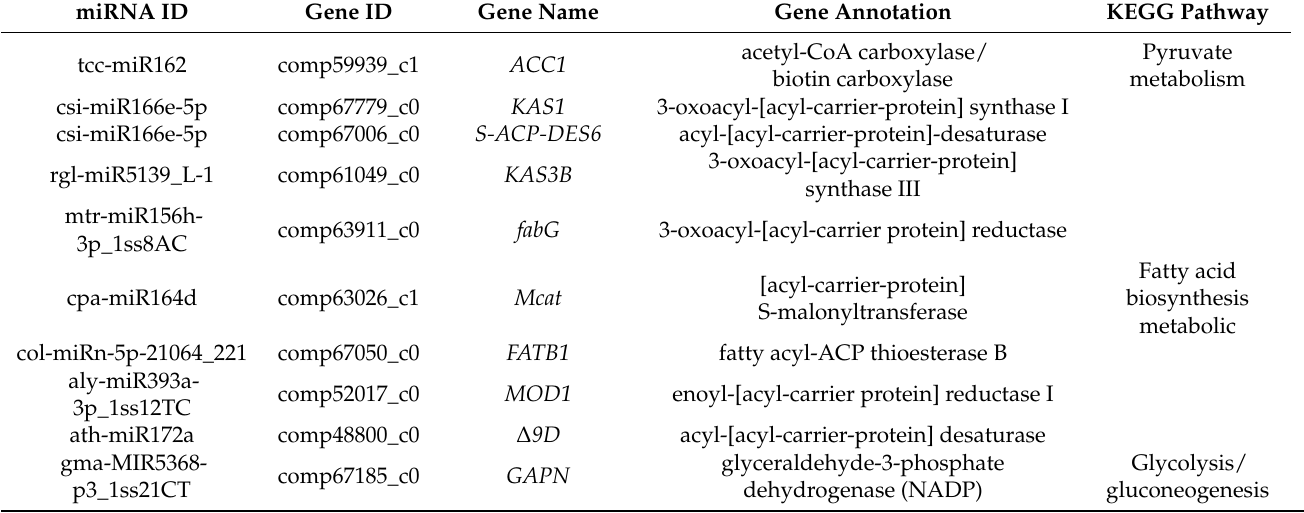
Table 1. Predicted miRNAs and their target genes involved in lipid